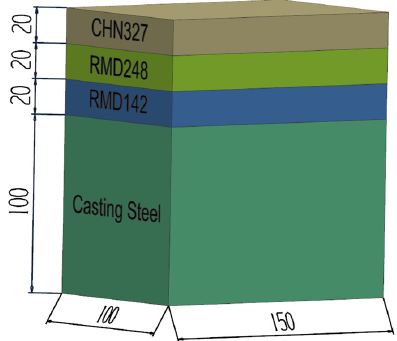
Figure 1. Schematic diagram and dimensions of sample (unit: mm).